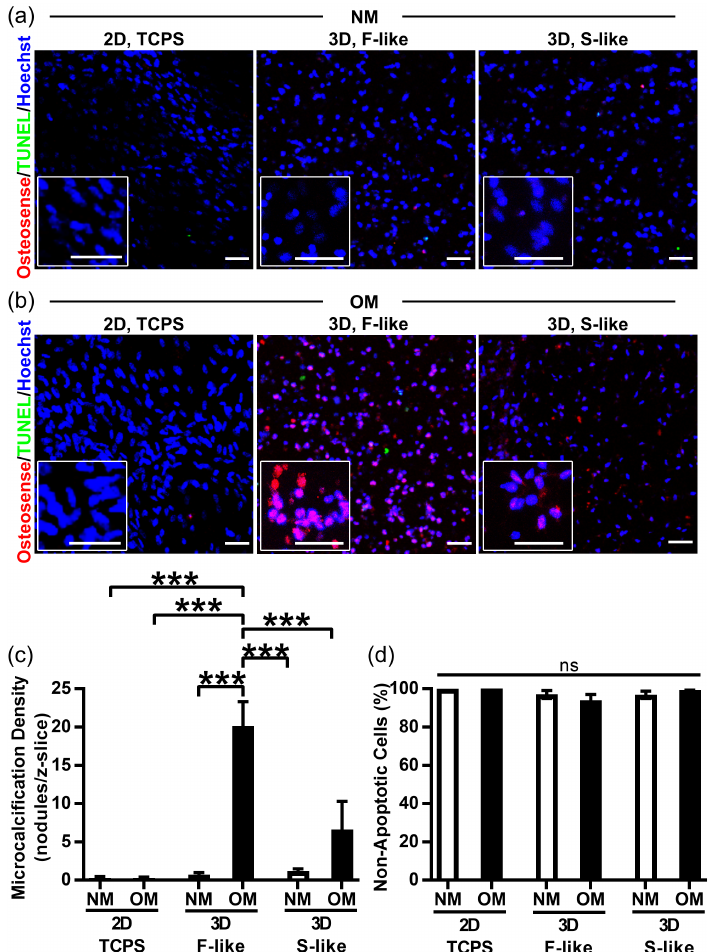
Figure 5. Fibrosa-like hydrogels preferentially induced production of osteogenic microcalcification by VICs. Red = NIRF Osteosense 680 imaging agent (nano- and microcalcifications), green = TUNEL apoptosis assay, blue = Hoechst nuclear stain: ( a ) VICs isolated from non-diseased human AV did not undergo calcification when cultured in NM on/in either 2D tissue culture polystyrene (TCPS), 3D fibrosa-like (F-like) hydrogels, or 3D spongiosa-like (S-like) hydrogels (representative images); ( b , c ) Importantly, under OM treatment this naïve VIC population developed significant production of microcalcification only in 3D F-like hydrogels that mimic the biomechanics of the disease-prone layer of the native tissue. OM treatment did not induce significant microcalcification on 2D TCPS or in 3D S-like hydrogels. ( d ) Apoptosis was negligible and unchanged across all conditions, confirming that apoptotic cell death was not the source of preferential calcification in OM-treated F-like hydrogels. Mean + SEM; *** p < 0.001; n = 3 samples per condition (3 images per sample); scale bar = 50 µ